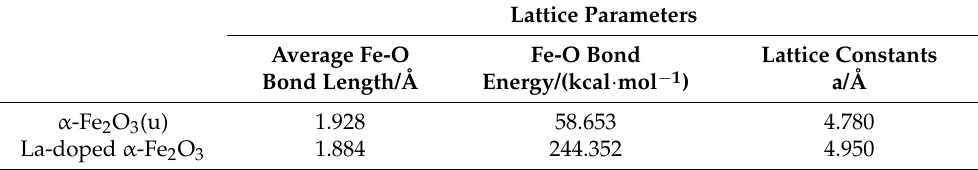
Figure 5. Crystal lattice of α -Fe 2 O 3 (u) or La-doped α -Fe 2 O 3 (Yellow ball is O; red ball is Fe; green ball is La). ( a ) α -Fe 2 O 3 (u); ( b ) La-doped α -Fe 2 O 3 . Table 3. Simulated lattice parameters.